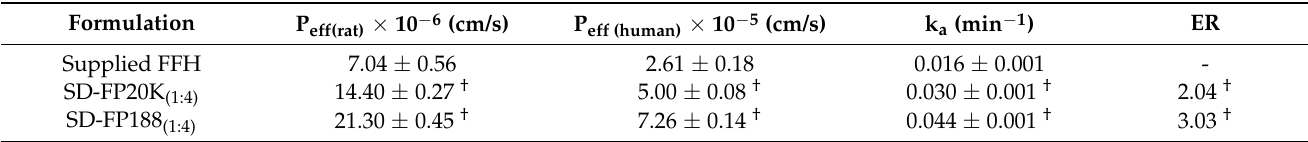
Table 3. In situ absorption parameters of fexofenadine hydrochloride from the prepared solid dispersions across rat intestine (Mean ± SD; n =